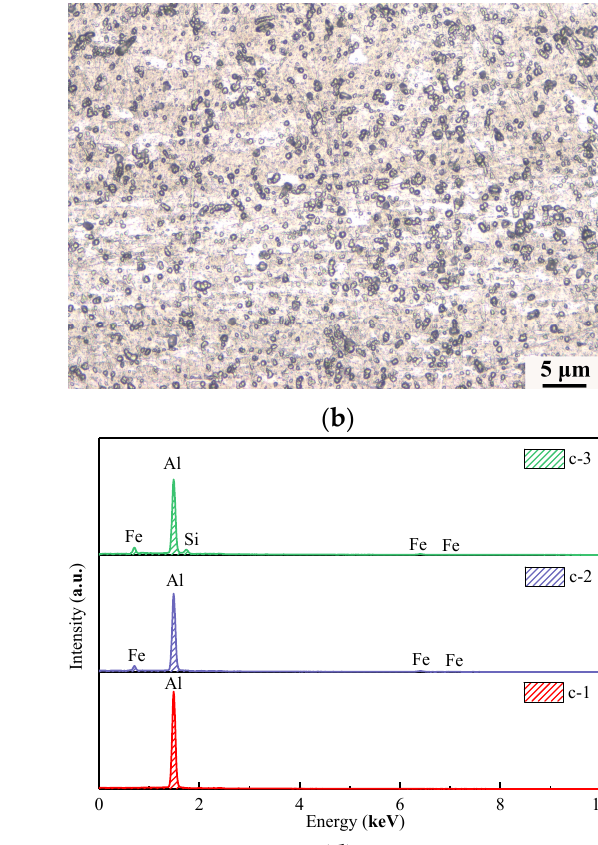
Figure 3. Macrostructural characteristics of wires at their rated currents: ( a ) metallographic structure of aluminum wires and; ( b ) aluminum alloy wires; ( c ); SEM image; ( d ) EDS analysis.